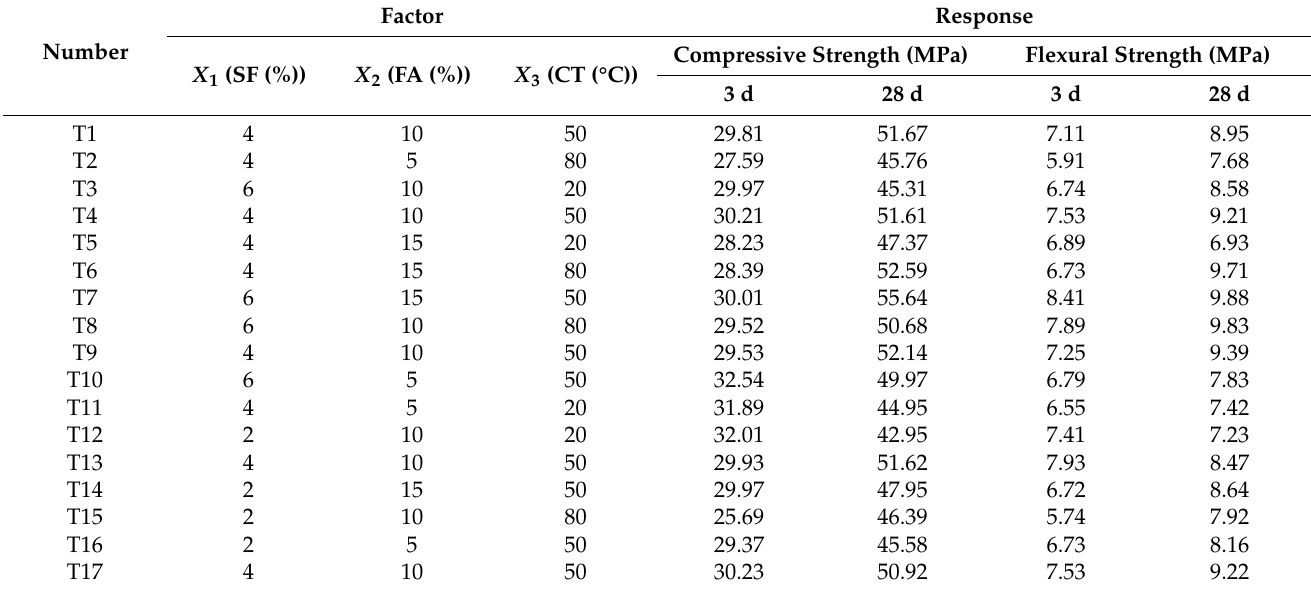
Table 3. Box–Behnken experimental design and response